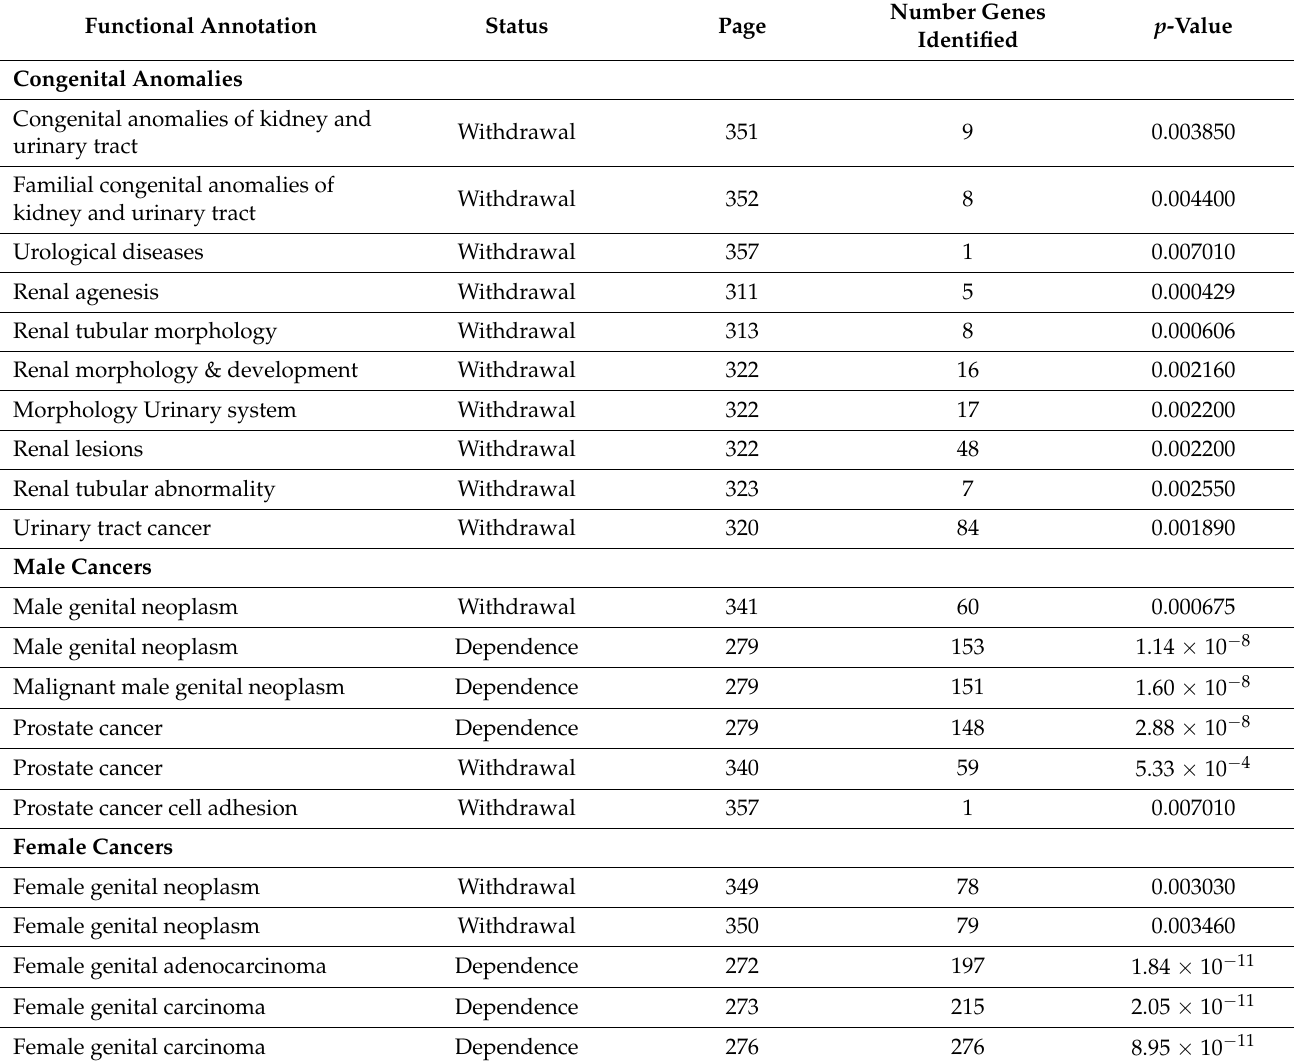
Table 16. EWAS Hits from Schrott Dataset for Significantly Differentially Methylated Regions for.Uronephrological Congenital